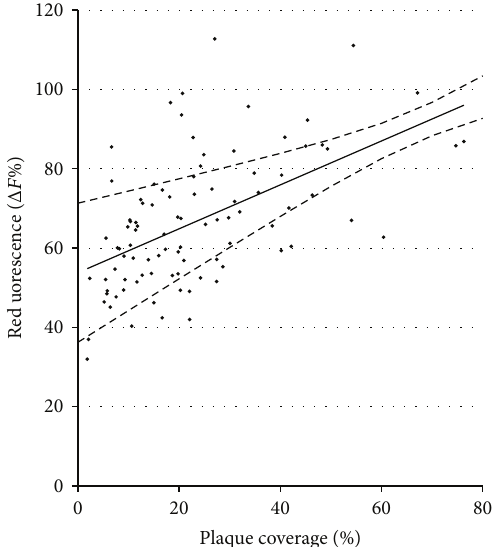
Figure 4: Pearson product-moment correlation coefficient (0.55) between plaque coverage (%) and red fluorescence ( Δ𝑅 %) showing line of best fit (black line) and 95% confidence intervals (dashed